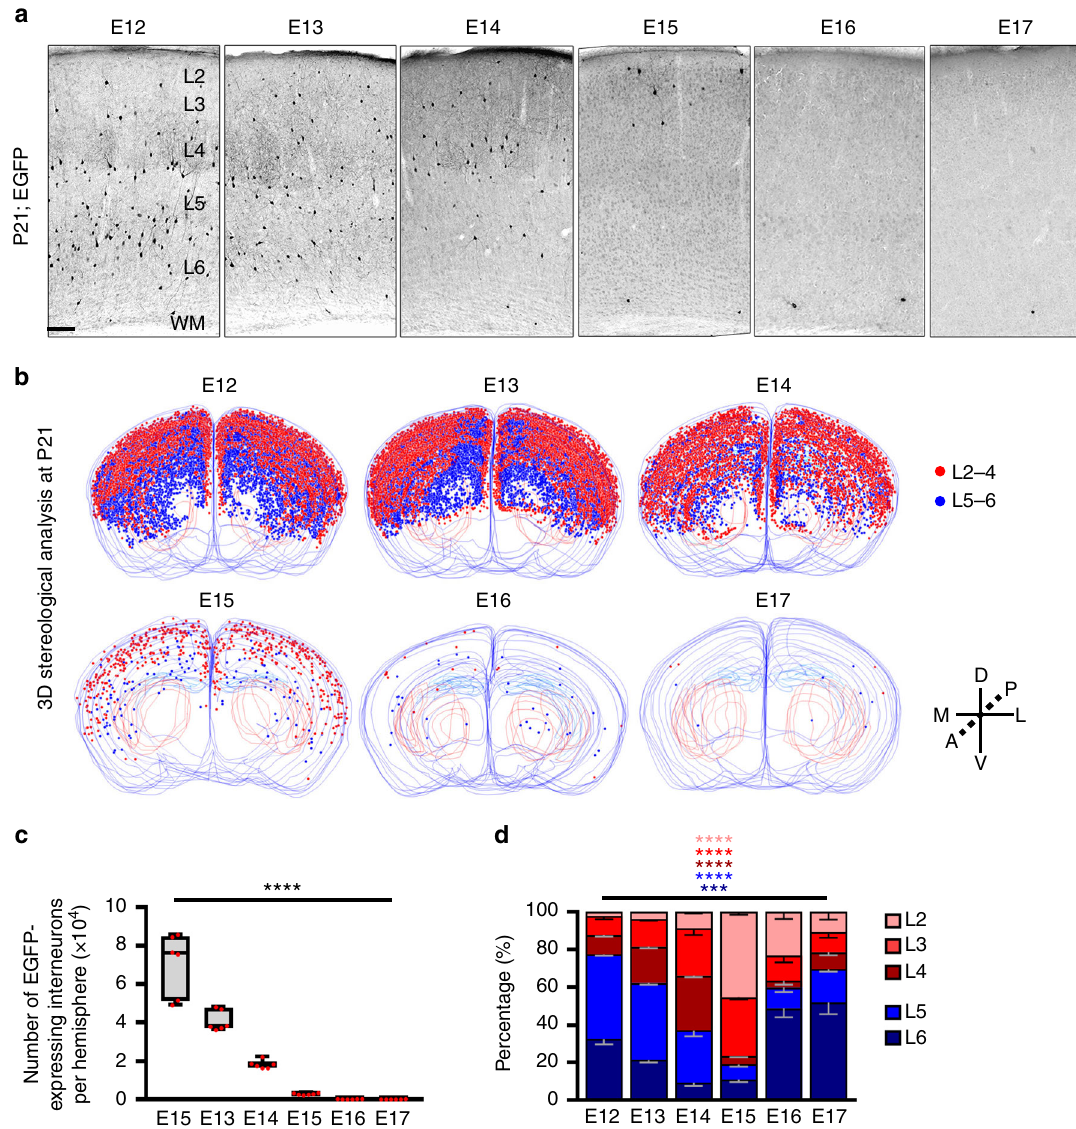
Fig. 1 Progressive changes in neocortical interneuron output of dividing NKX2.1 + MGE/PoA RGPs. a Images of the somatosensory cortex of representative P21 mouse brains that received in utero intraventricular injection of high-titer EGFP-expressing retrovirus at E12-E17. EGFP-labeled interneurons are shown in black. L, layer; WM, white matter. Scale bar: 150 μ m. b 3D reconstruction images of P21 brains that received in utero retrovirus injection at different embryonic stages. Blue lines indicate the contours of the whole brain. Red and blue dots represent the cell bodies of the EGFP-expressing interneurons in the super fi cial (L2-4) and deep (L5/6) layers of the neocortex, respectively. A anterior, P posterior, D dorsal; V ventral. c Quanti fi cation of the total number of EGFP-expressing interneurons per hemisphere of the neocortex. ( n = 6 hemispheres per time point from at least three different animals). Center line, median; box, interquartile range; whiskers, minimum and maximum. Red dots indicate individual data points. **** P < 0.0001 ( P = 3.4e-13, Jonckheere – Terpstra test). d Quanti fi cation of the laminar distribution of EGFP-expressing interneurons. Data are presented as mean ± SEM ( n = 6 hemispheres per time point from at least three different animals). *** P = 0.0001; **** P < 0.0001 (Kruskal-Wallis